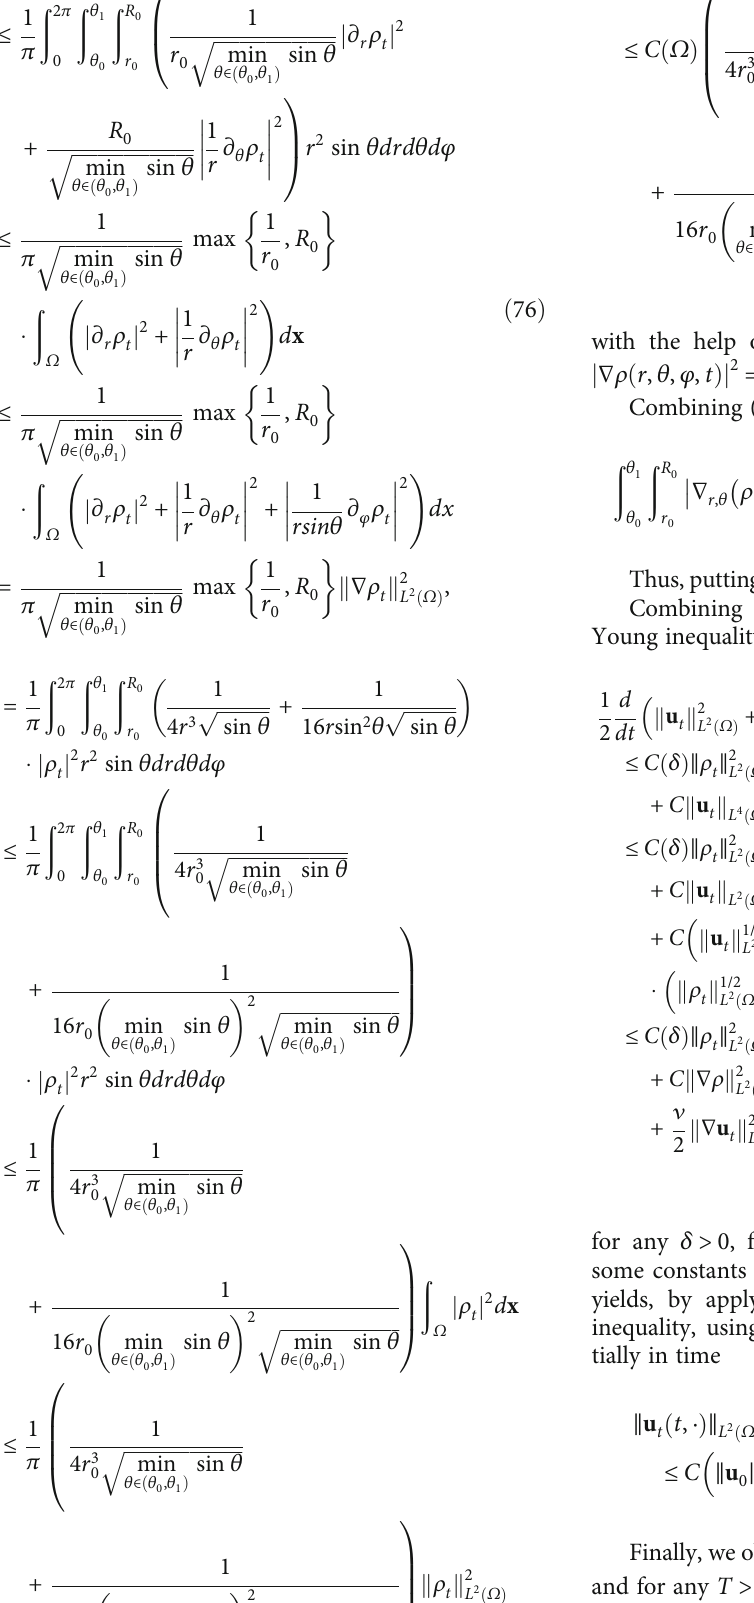
ffiffiffiffiffiffiffiffiffiffiffiffiffiffiffiffiffiffiffiffiffiffiffiffi min